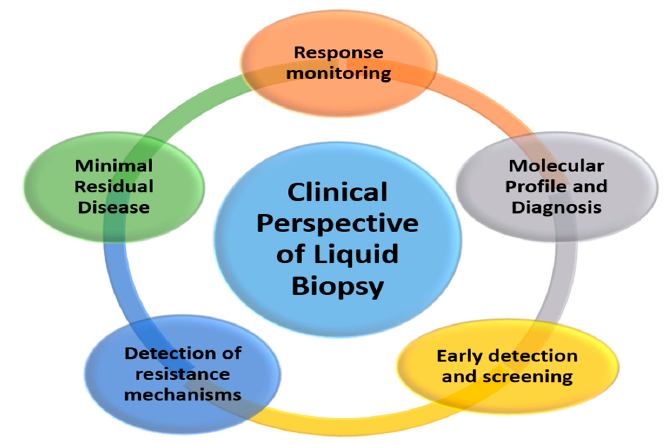
Figure 2. Potential clinical applications of liquid biopsy.